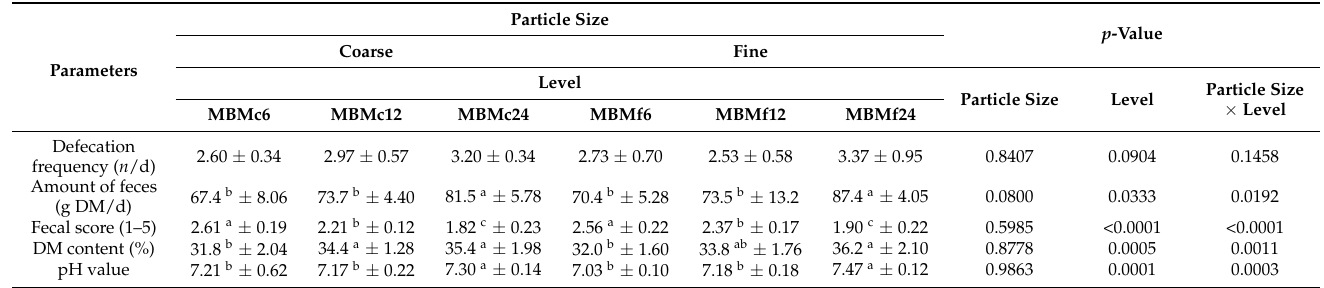
Table 3. Fecal characteristics of dogs fed the basic diets supplemented with different levels and particle sizes of MBM (mean ± SD).